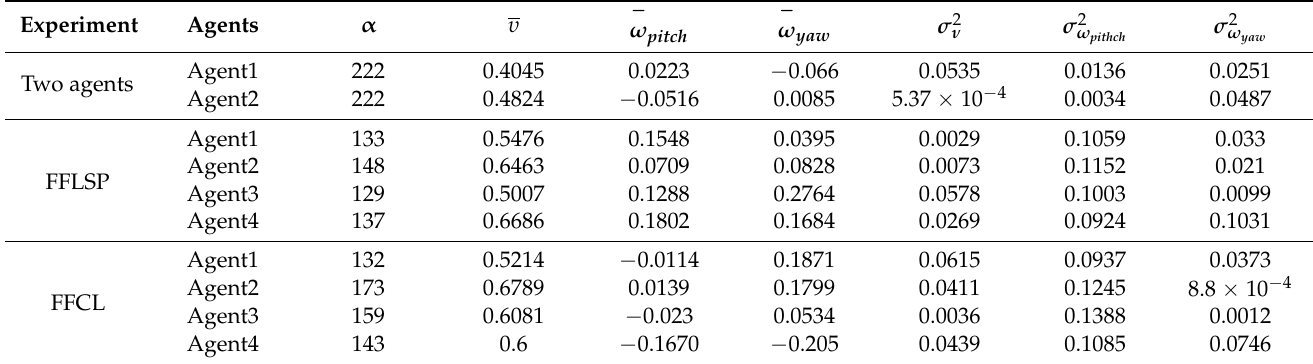
Table 8. Dynamic obstacle avoidance: numerical